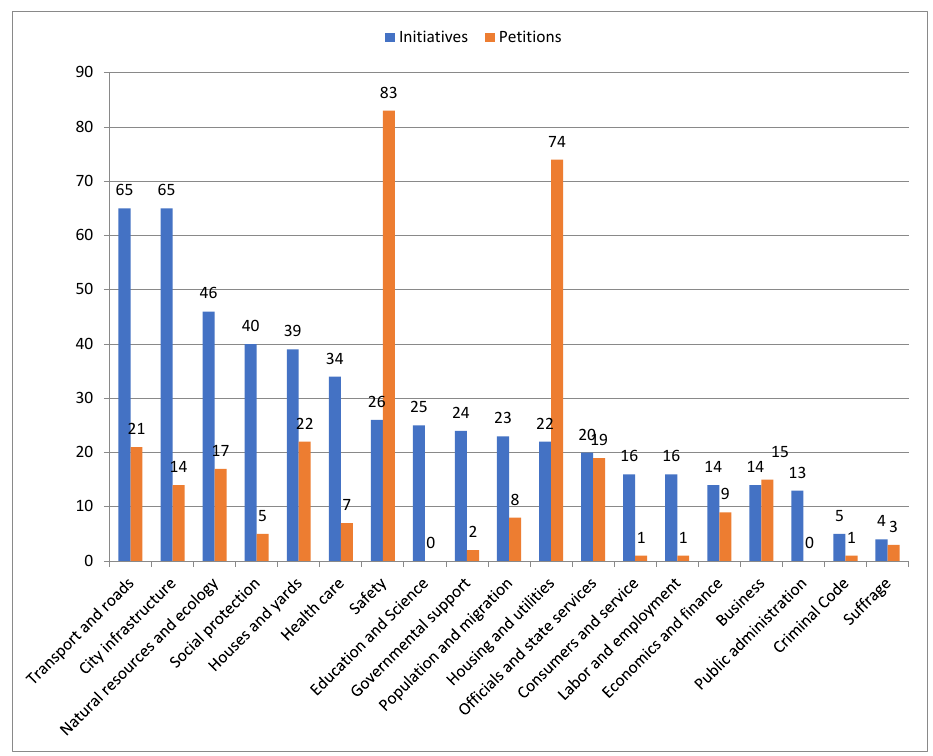
Figure 2. Thematic focus of public initiatives and petitions (regional level) (data from the Russian Public Initiative and Change.org Internet platforms, March 2020–March 2021) (number of initiatives and petitions).